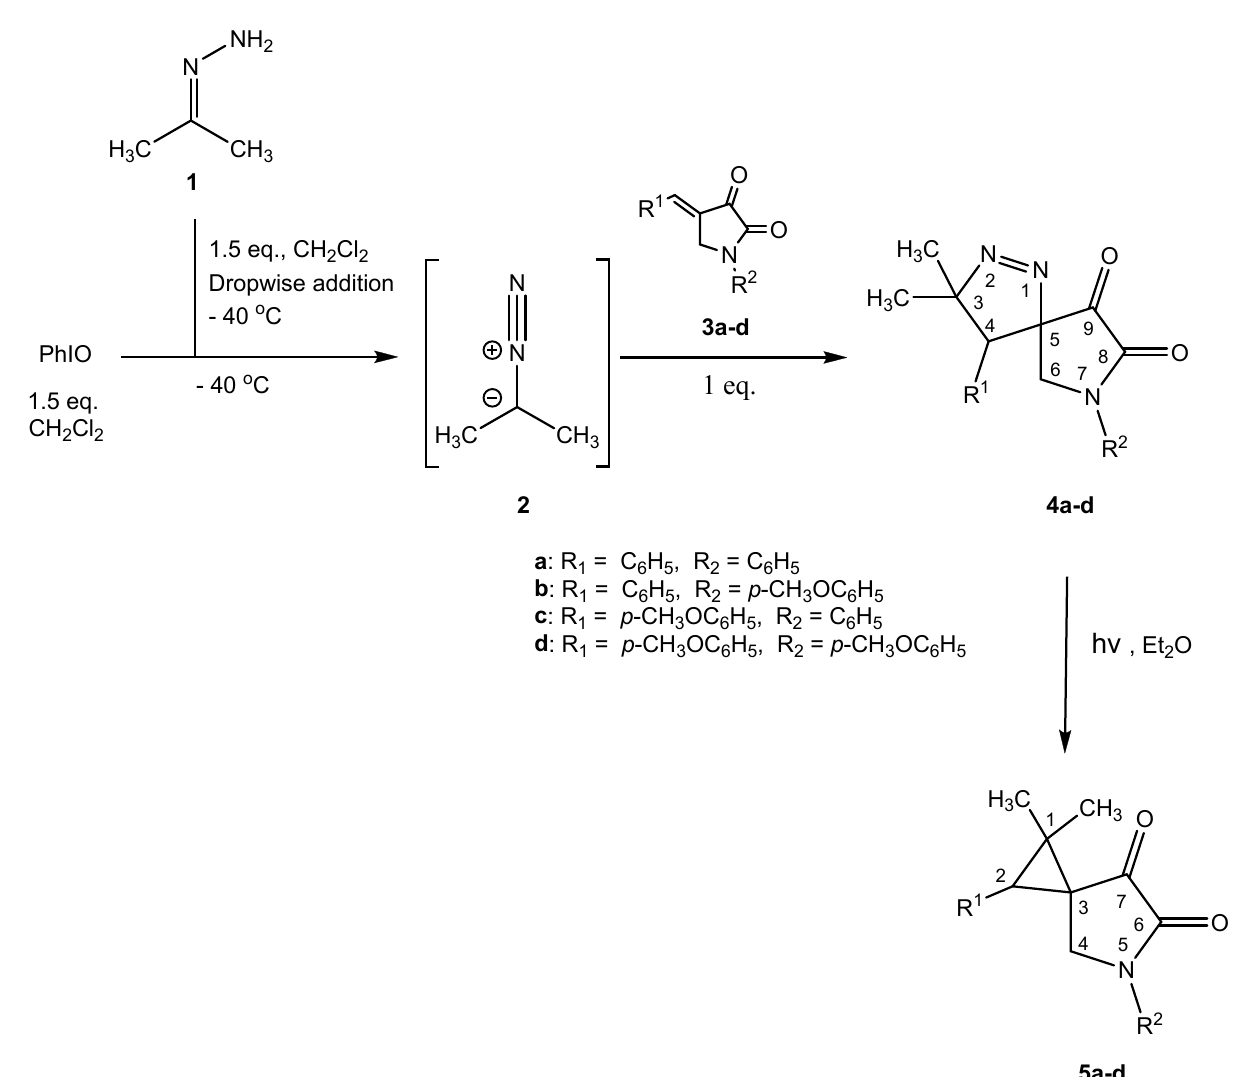
Scheme 1. Synthesis and evolution of spiro pyrazole derivatives by cycloaddition of ( E )-4-arylidene- pyrrolidine-2,3-dione derivatives with 2-diazopropane prepared by oxidizing with